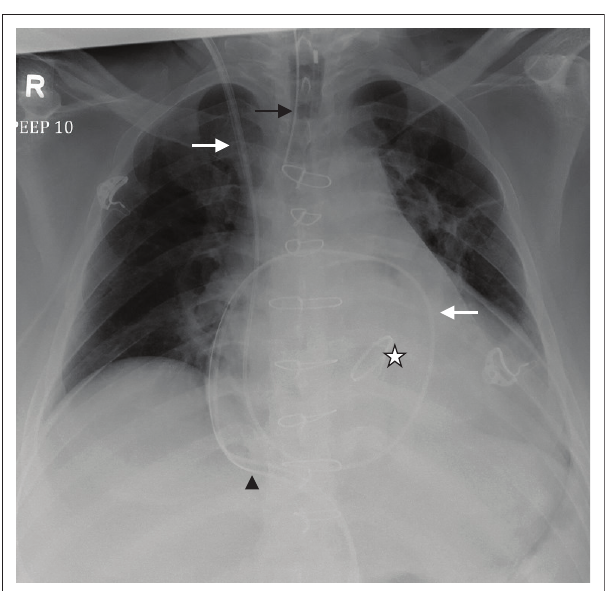
FIGURE 8: Chest radiograph showing a Swan Ganz or pulmonary artery catheter (white arrow), with its tip in the right pulmonary artery. The other devices